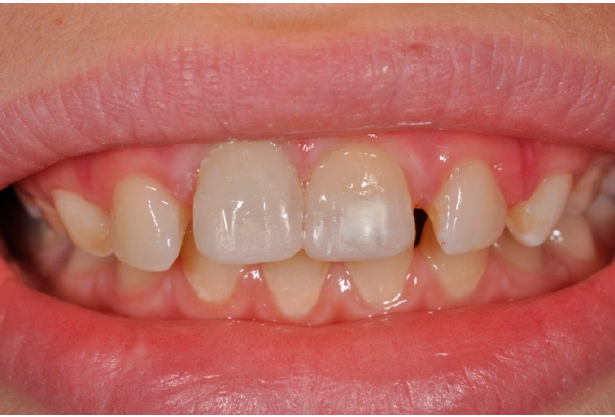
Figure 6. Clinical image showing the definitive restorations of 11 and 21 dental crowns.